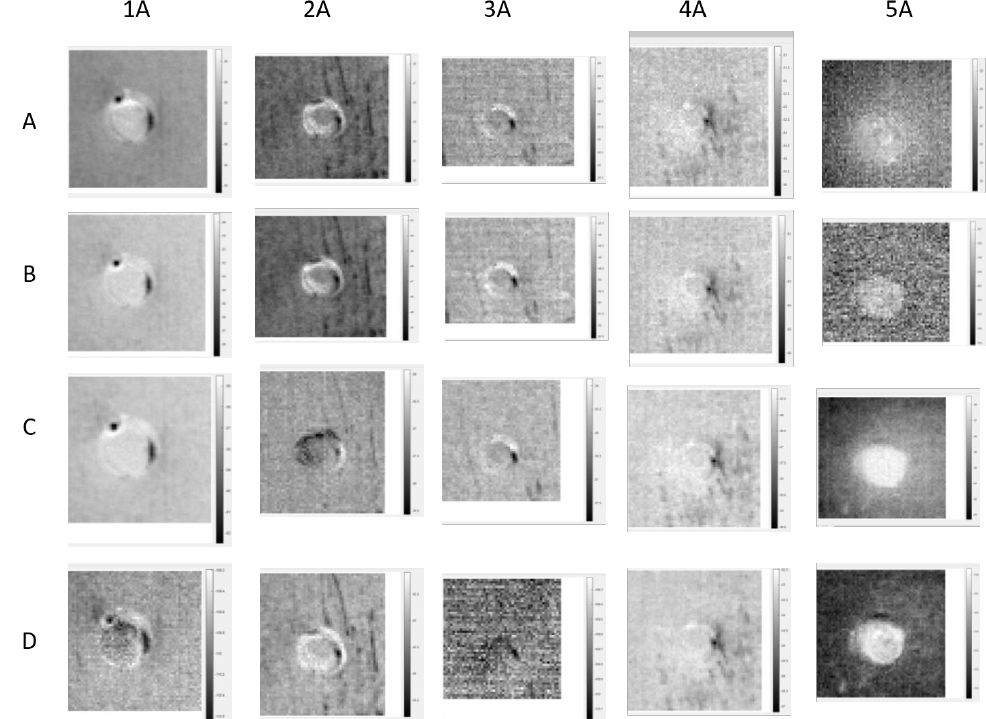
Figure 6. Snapshots taken from the fast Fourier transform analysis performed on pulse thermography data. Experiment ( A ) is performed using a pulse duration of 1s and a Fourier frequency of 0.038 Hz. Experiment ( B ) has a pulse duration of 1 s as well and is analysed using a Fourier frequency of 0.076 Hz. A pulse duration of 3 s is used for experiments ( C , D ), and the used Fourier frequencies are 0.035 Hz and 0.142